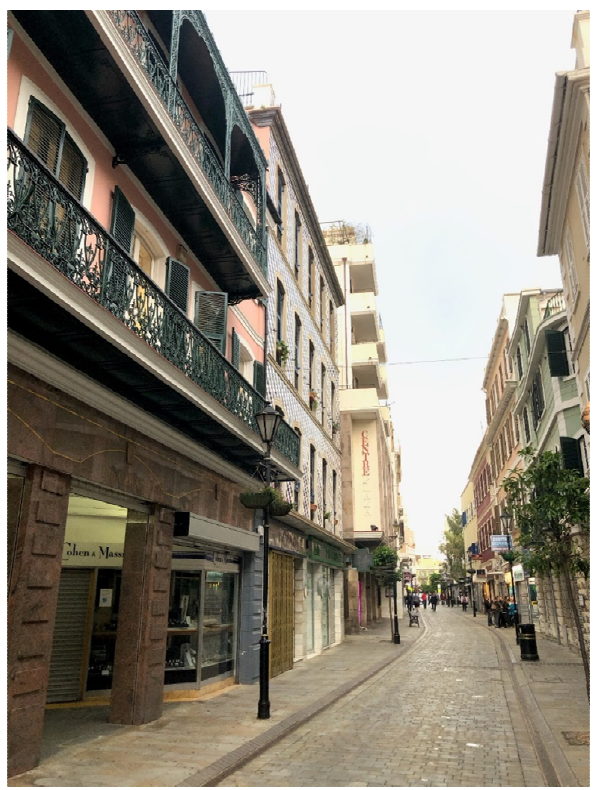
Figure 4. Main Street and the Centre Plaza building.